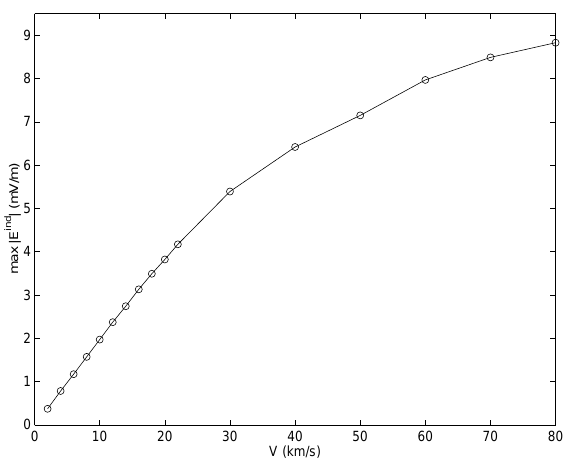
Fig. 12. The peak magnitude of the induced electric field for dif- ferent velocities of the WTS